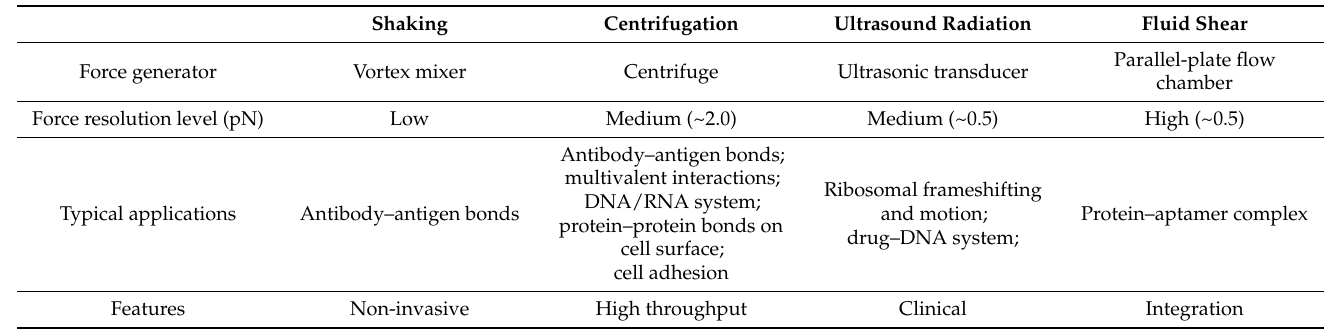
Table 1. Comparison of the external mechanical force in